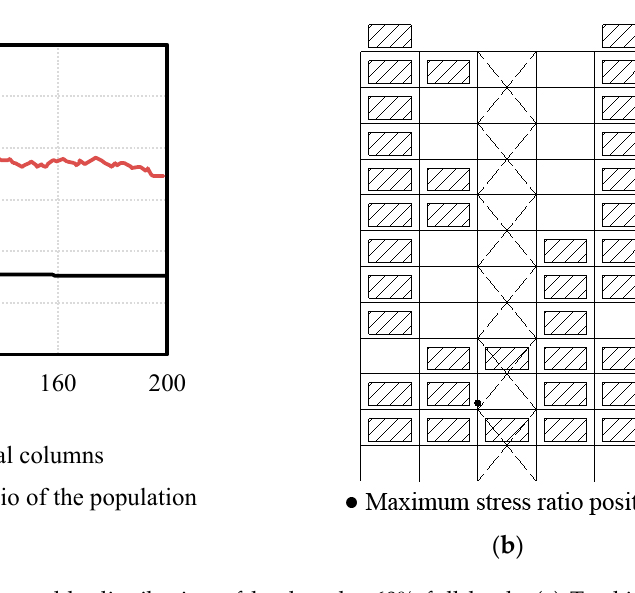
Figure 11. The most favorable distribution of load under 60% full load. ( a ) Tracking chart of optimization performance of GA. ( b ) The most favorable distribution of load (H = 5.72, P = 0).